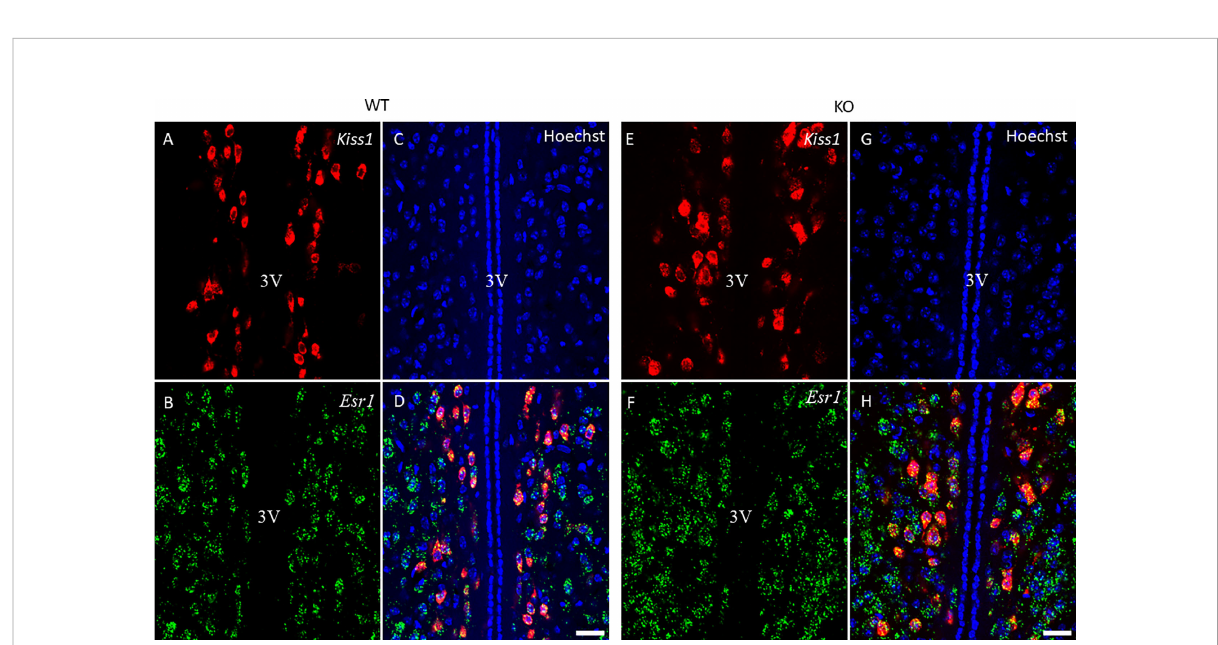
FIGURE 5 Kiss1 and Esr1 mRNA expression in the RP3V of wild-type and PACAP KO female mice. Representative confocal fl uorescence images depict the expression of Kiss1 mRNA in the RP3V region (panels A, E ) and Esr1 mRNA-positive cells in the RP3V (panels B, F ) of WT and PACAP KO mice. Nuclear counterstain with Hoechst33342 is presented in panels (C, G) while the merged image is shown in panels D, H . 3V, third ventricle. Images were taken with a 20× plan apochromat objective (scale bar: 100